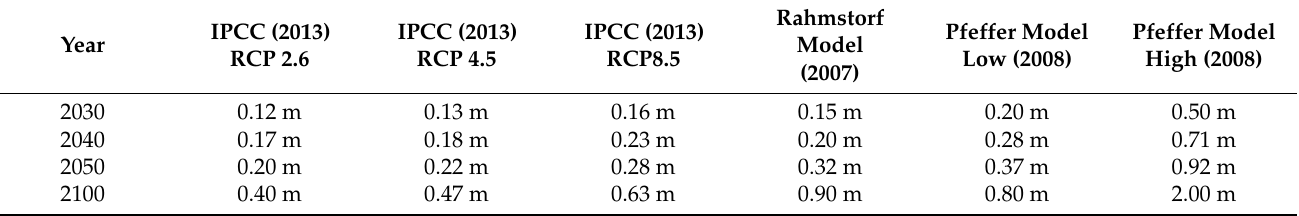
Table 2. Global sea-level rise (GSLR) projecting the years 2030, 2040, 2050, and 2100, according to the different models and